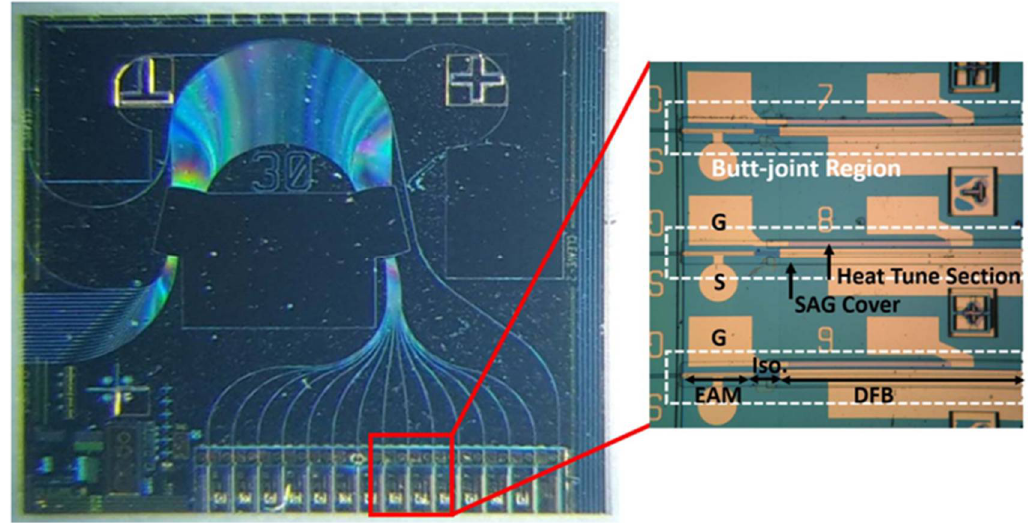
Figure 1. Integrated parallel DFB laser array [8] © Springer link. Copyright 2018 Science China Information Sciences.